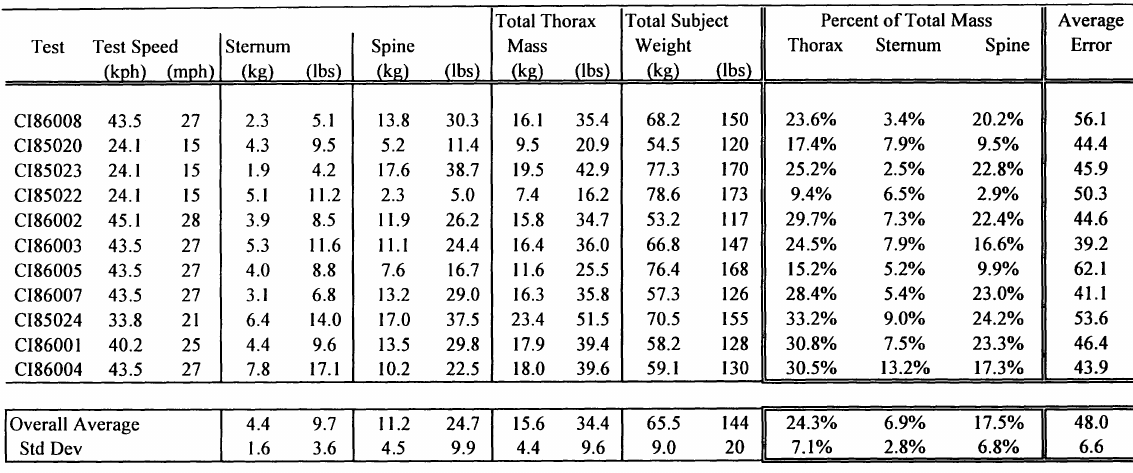
Table 11. CIRA Frontal Impact Sled Tests with Cadaveric